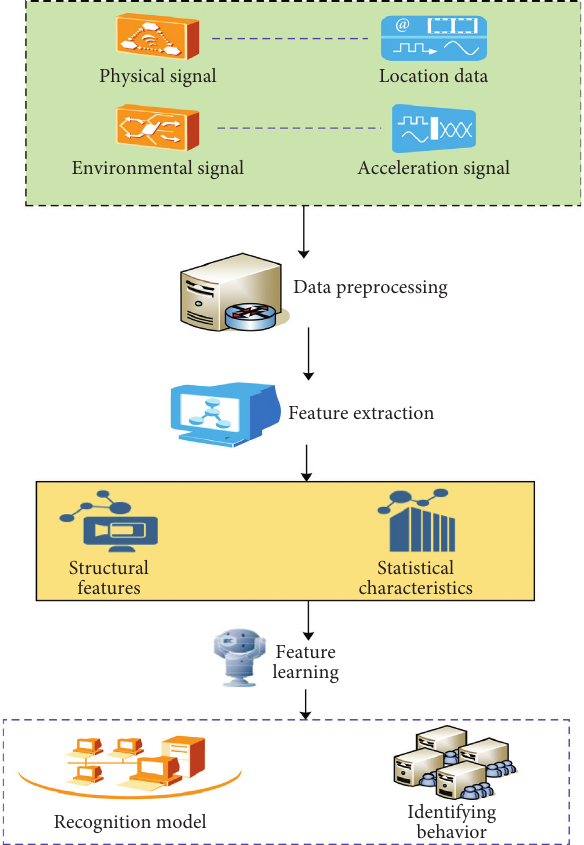
Figure 4: Flow chart of moving target